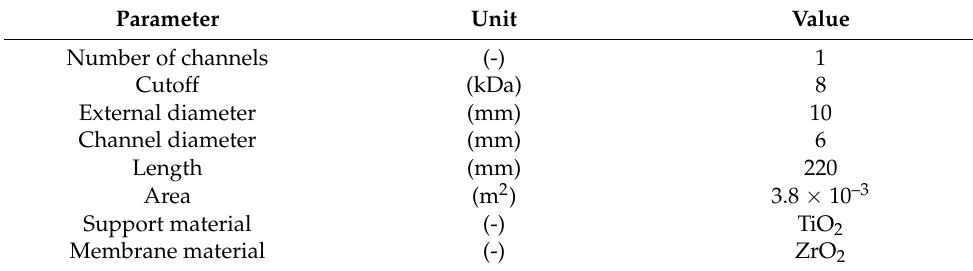
Table 1. Technical data on the UF membrane used in this